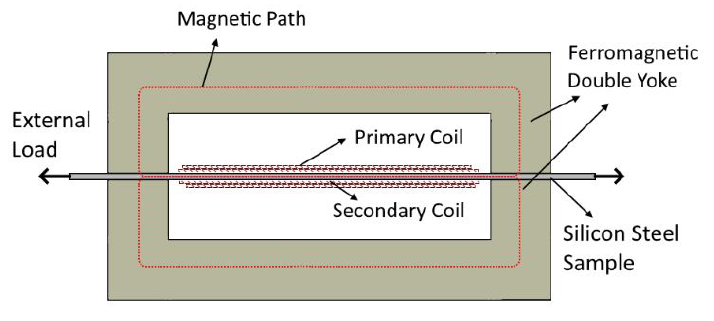
Figure 2. Illustrated cross section view of the double yoke setup used for performing magnetic measurements.